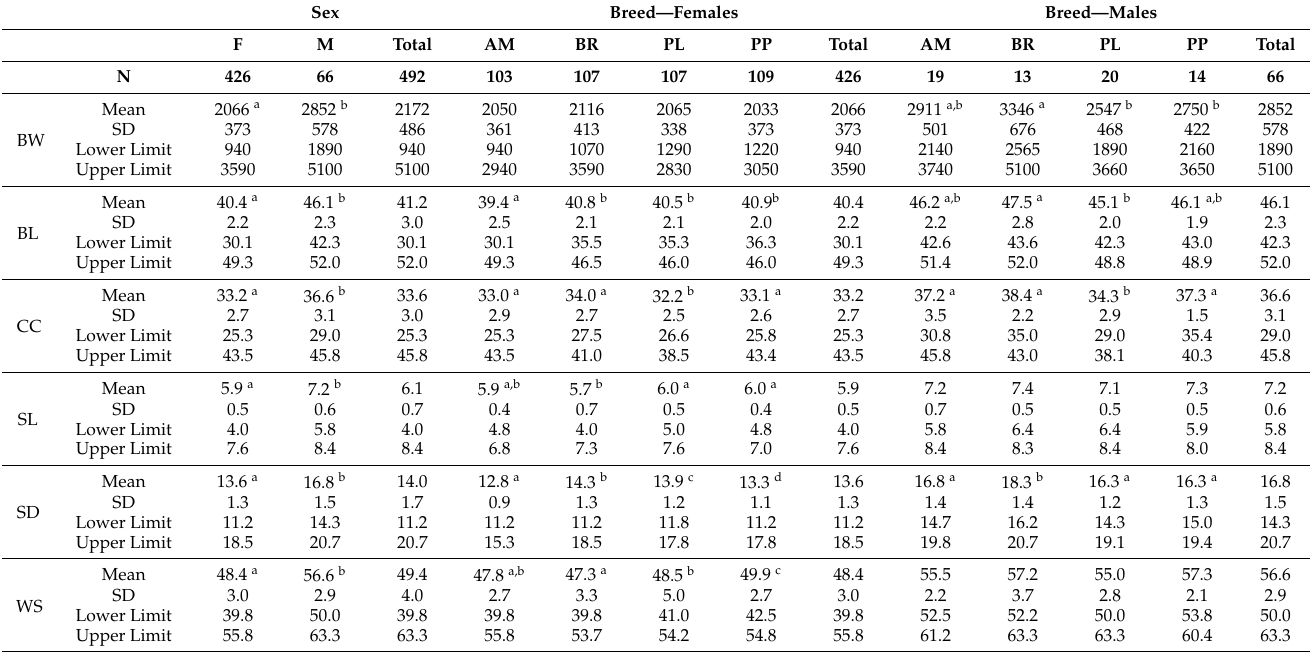
Table 2. Effects of sex and sex*breed interaction in the different zoometric measures (cm) and body weight (g) in Portuguese poultry breeds. Sex Breed—Females